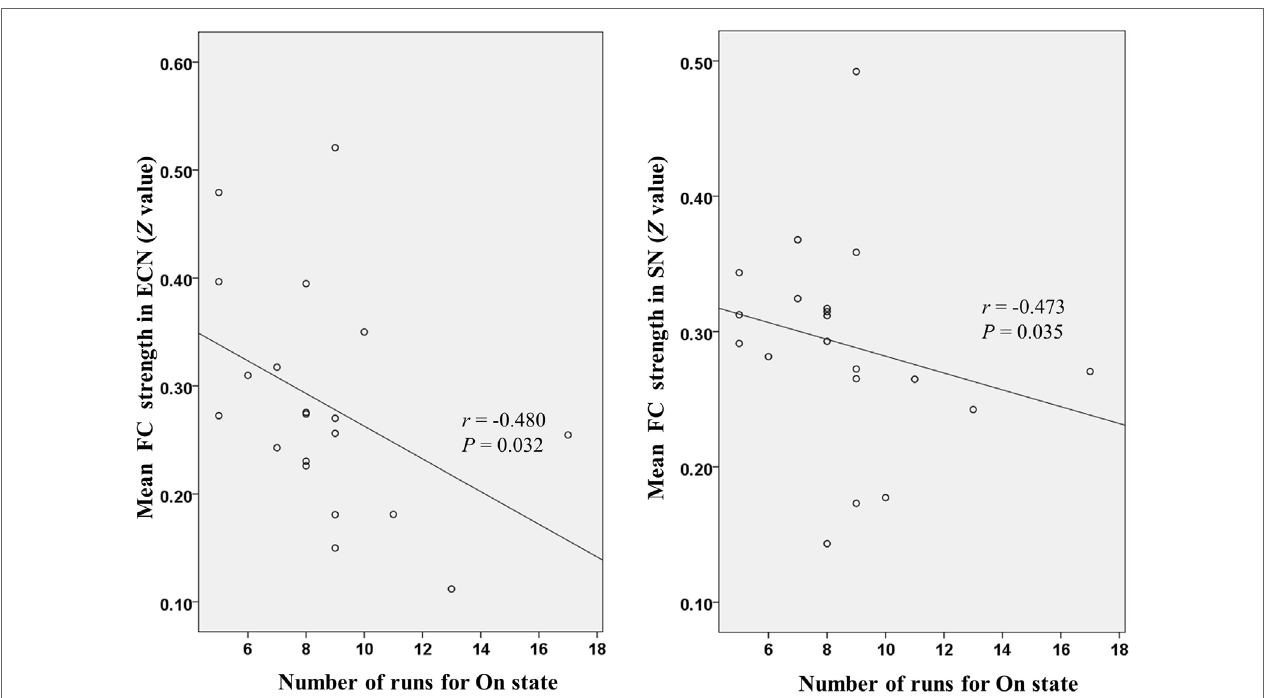
FigUre 4 | Scatter plots depicting correlations between Stroop task results (i.e., number of runs for the “On” state) and mean functional connectivity (FC) strength within the executive control network (ECN) and salience network (SN) in the patient